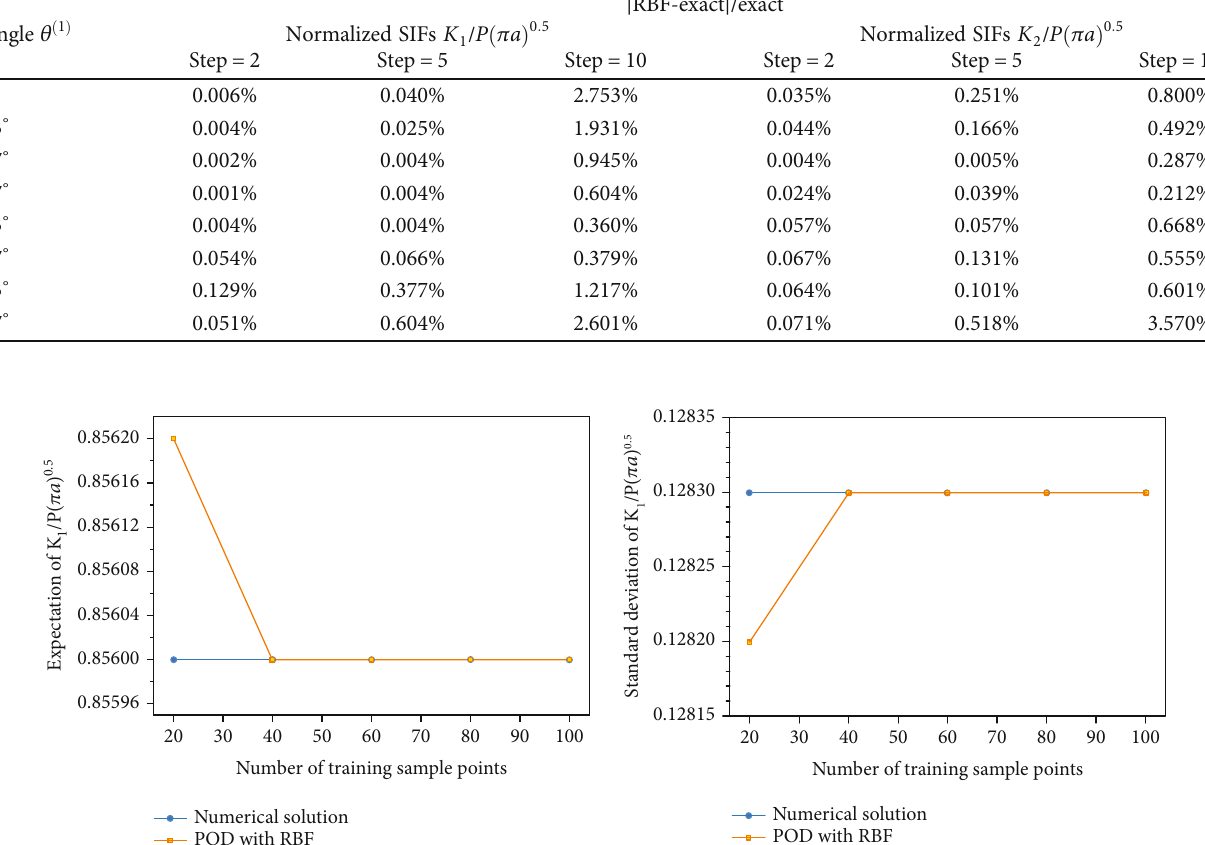
/ P ð π a Þ 0 : 5 under 1